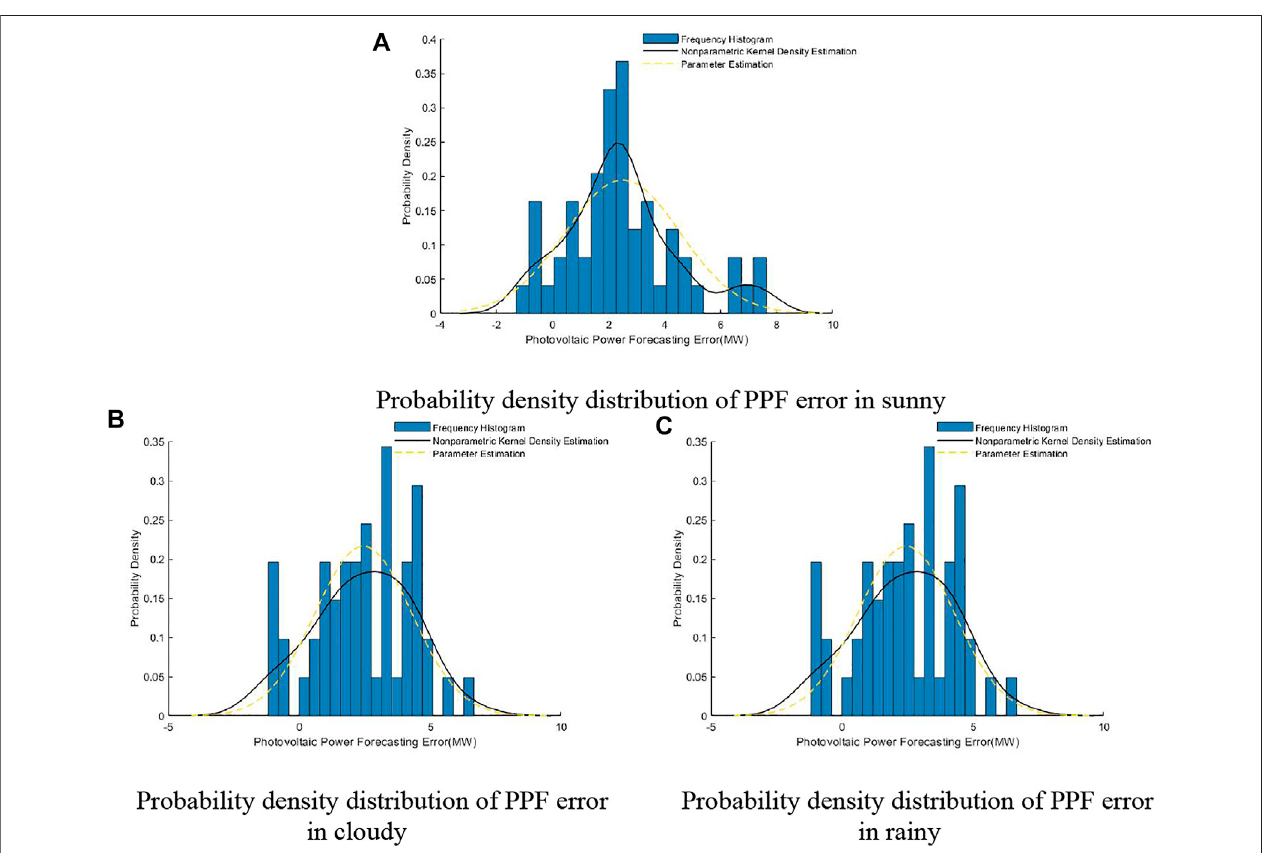
FIGURE 11 | Probability density distribution of